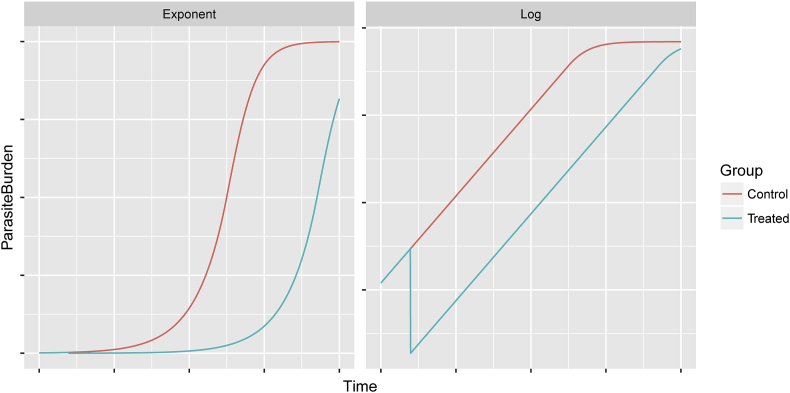
Graphical illustration of the theoretical relationship between an exponentially increasing true parasite burden on the exponent scale (left) and the log of the same quantity (right) over time. A proportional reduction in the simulated ‘treated’ (blue) mean occurring 1/10 into the time span results in the log of the two quantities increasing in parallel during the exponential phase of the control mean (red). This exponential phase ends around 6/10 into the time span, after which a plateau can be seen on the exponent scale and the lines cease to be parallel on the log scale. (For interpretation of the references to colour in this figure legend, the reader is referred to the Web version of this article.)